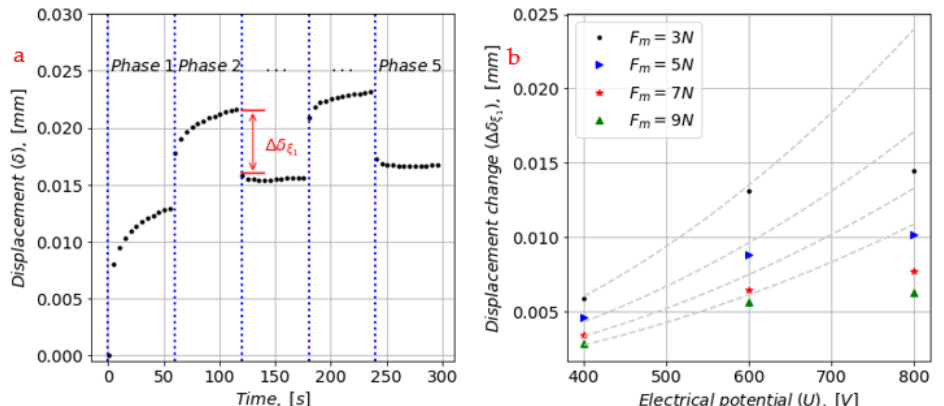
Figure 8. ( a ) The instant change in displacement ( ∆ δ ξ ) in Phase 2. ( b ) The data for all load combina- tions of F m and U. Model predictions using scaled model parameters are shown with grey dashed lines (scaling factor of 10 is used to match data for U = 400 V).